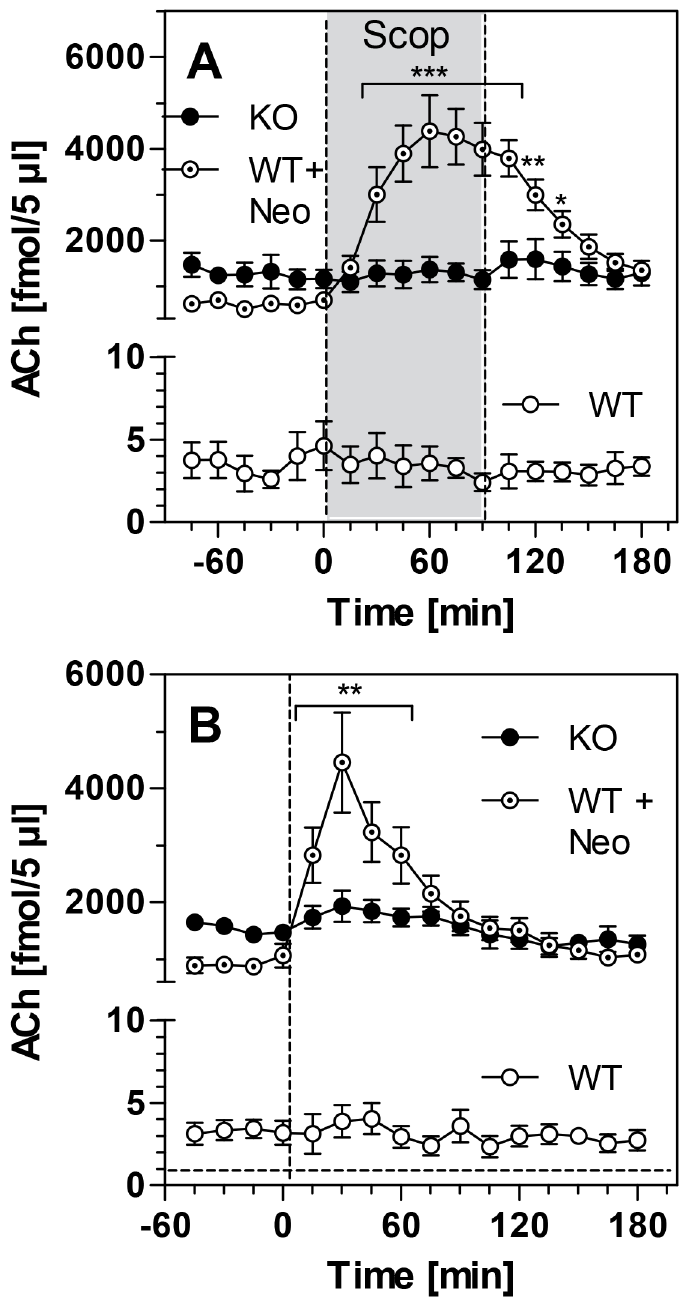
Fig 3. Acetylcholine (ACh) levels in murine striatum following administration of the M2 antagonist scopolamine. Data is presented for WT mice, WT+Neo mice (group of WT mice additionally receiving 1 μ M neostigmine through the microdialysis probe to raise ACh levels) and PRiMA KO mice. Data is presented as means ± SEM of 5 experiments and given as absolute values, not corrected for in-vitro recovery. (A) ACh levels measured during scopolamine infusion (SCOP, 1 μ M) indicated by grey area. (B) ACh levels measured after i.p. injection of scopolamine (0.5 mg/kg) at time-point zero (dashed line). Statistical significance was calculated by One-way ANOVA with Dunnett´s Multiple Comparison Test, using time point "0 min" as reference. * , p < 0.05; ** , p < 0.01; *** , p < 0.001 vs. time zero. Raw data are given in S1 File.